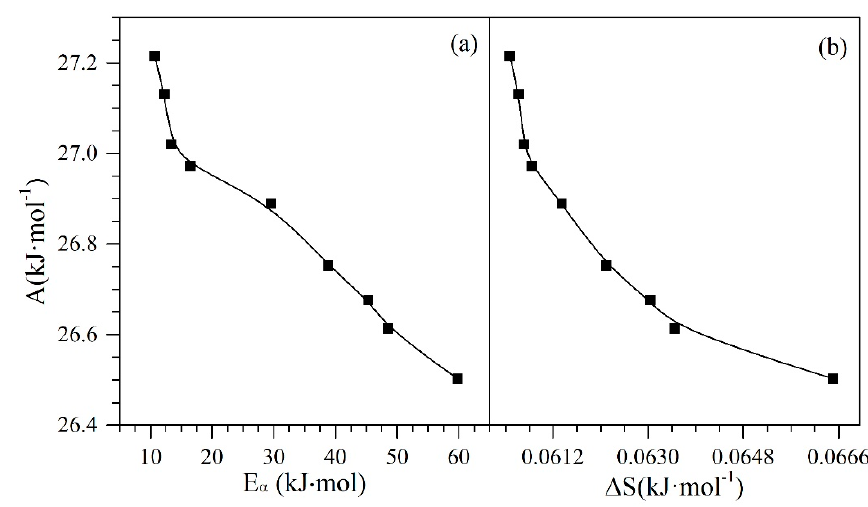
Figure 13. The relationship between Polanyi’s adsorption potential and ( a ) e ff ective activation energy and ( b ) entropy for n -C 7 asphaltene adsorption onto CeNi0.89Pd1.1 nanoparticles and subsequent catalytic steam decomposition through regeneration catalytic